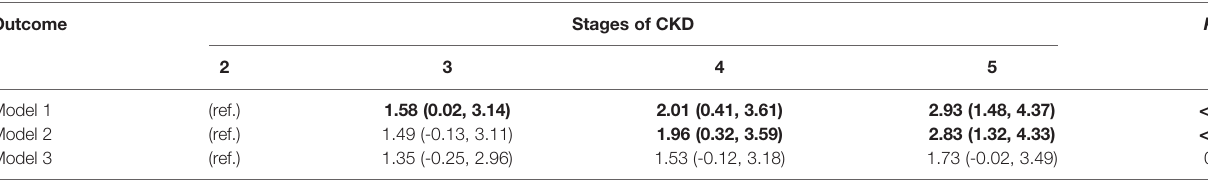
TABLE 3 | Association of the stages of CKD with PI. Outcome Stages of